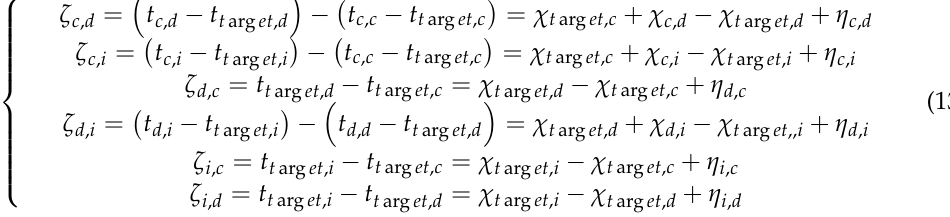
Figure 9. Location information